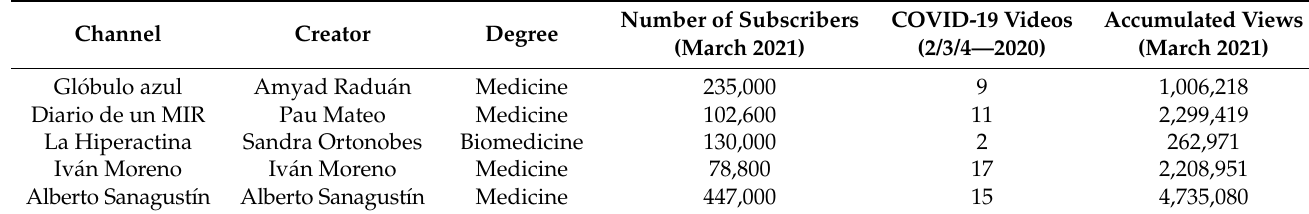
Table 1. YouTube channels included in the study